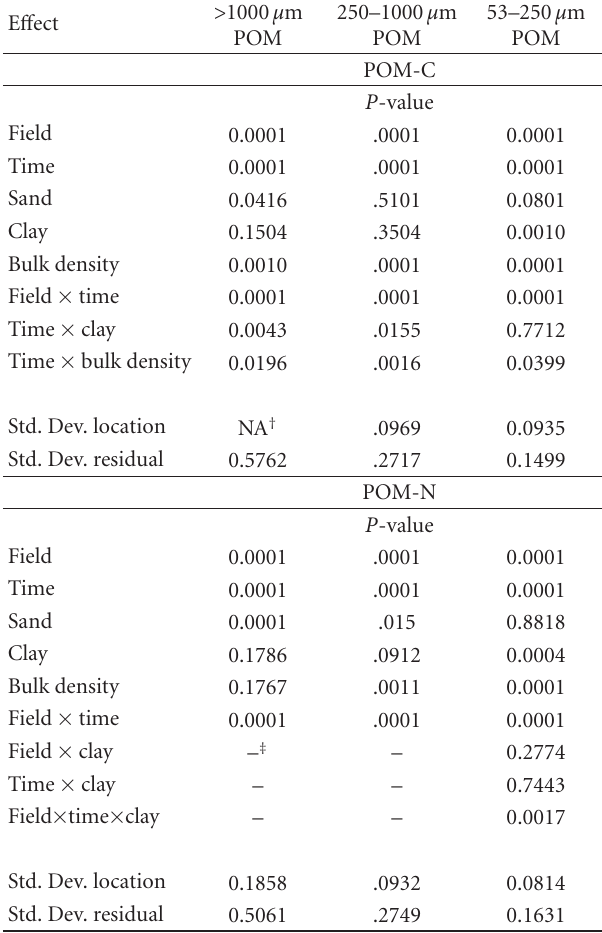
Table 6: Significance of e ff ects of soil physical properties on particulate organic matter (POM) C and N fractions, accounting for e ff ects of field and time. All POM fraction values were log-